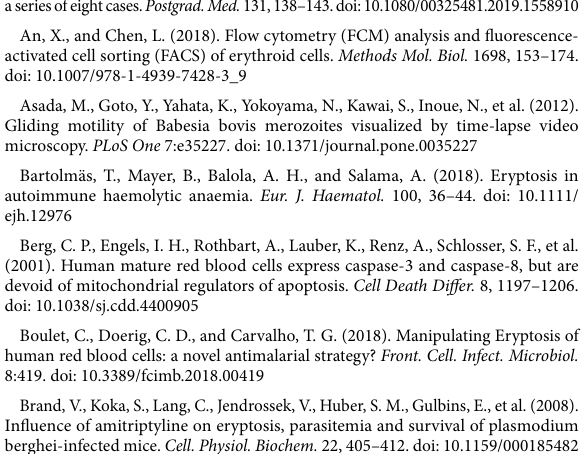
SUPPLEMENTARY FIGURE S1 General features changes of the spleen in non-infected and Babesia microti -infected mice. The weights (A) , lengths (B) , and images (C) of spleens in non-infected and Babesia microti -infected mice. SUPPLEMENTARY FIGURE S2 Morphologies of Babesia microti -infected erythrocytes in blood smears. Images of erythrocytes infected with Babesia microti at 0dpi (A) , 5dpi (B) , 10dpi (C) , 15dpi (D) , and 20 dpi (E)